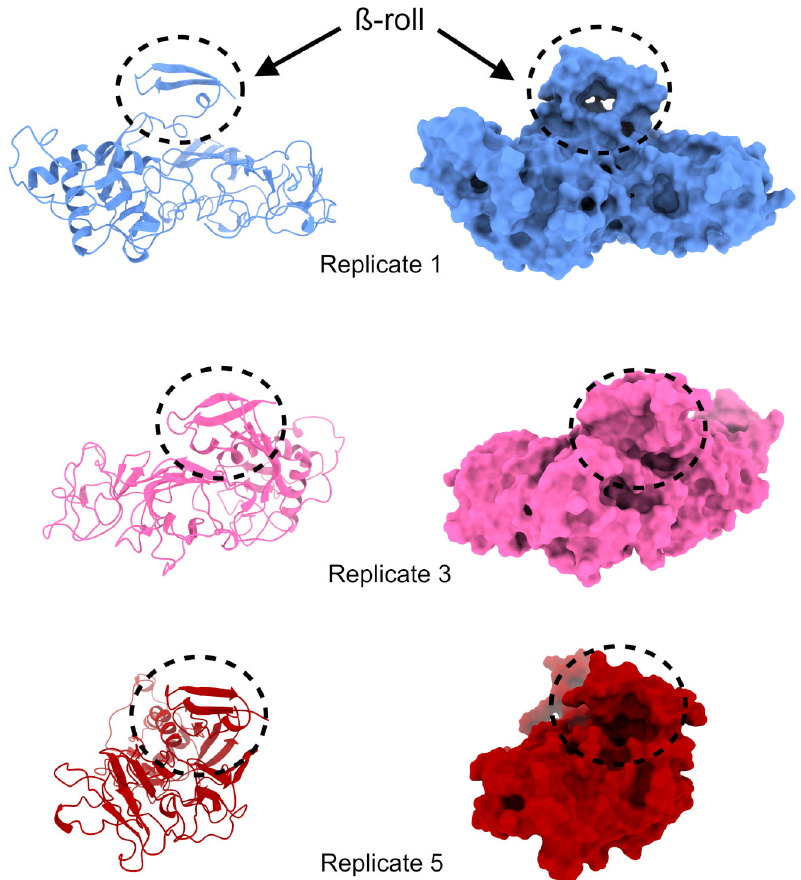
Figure 4. Structures selected for quercetin hydrate docking in the NS1 protein are represented as a ribbon and a surface for cavity visualization. The cavity comprising the ß-roll is demarcated in the black dashed lines.